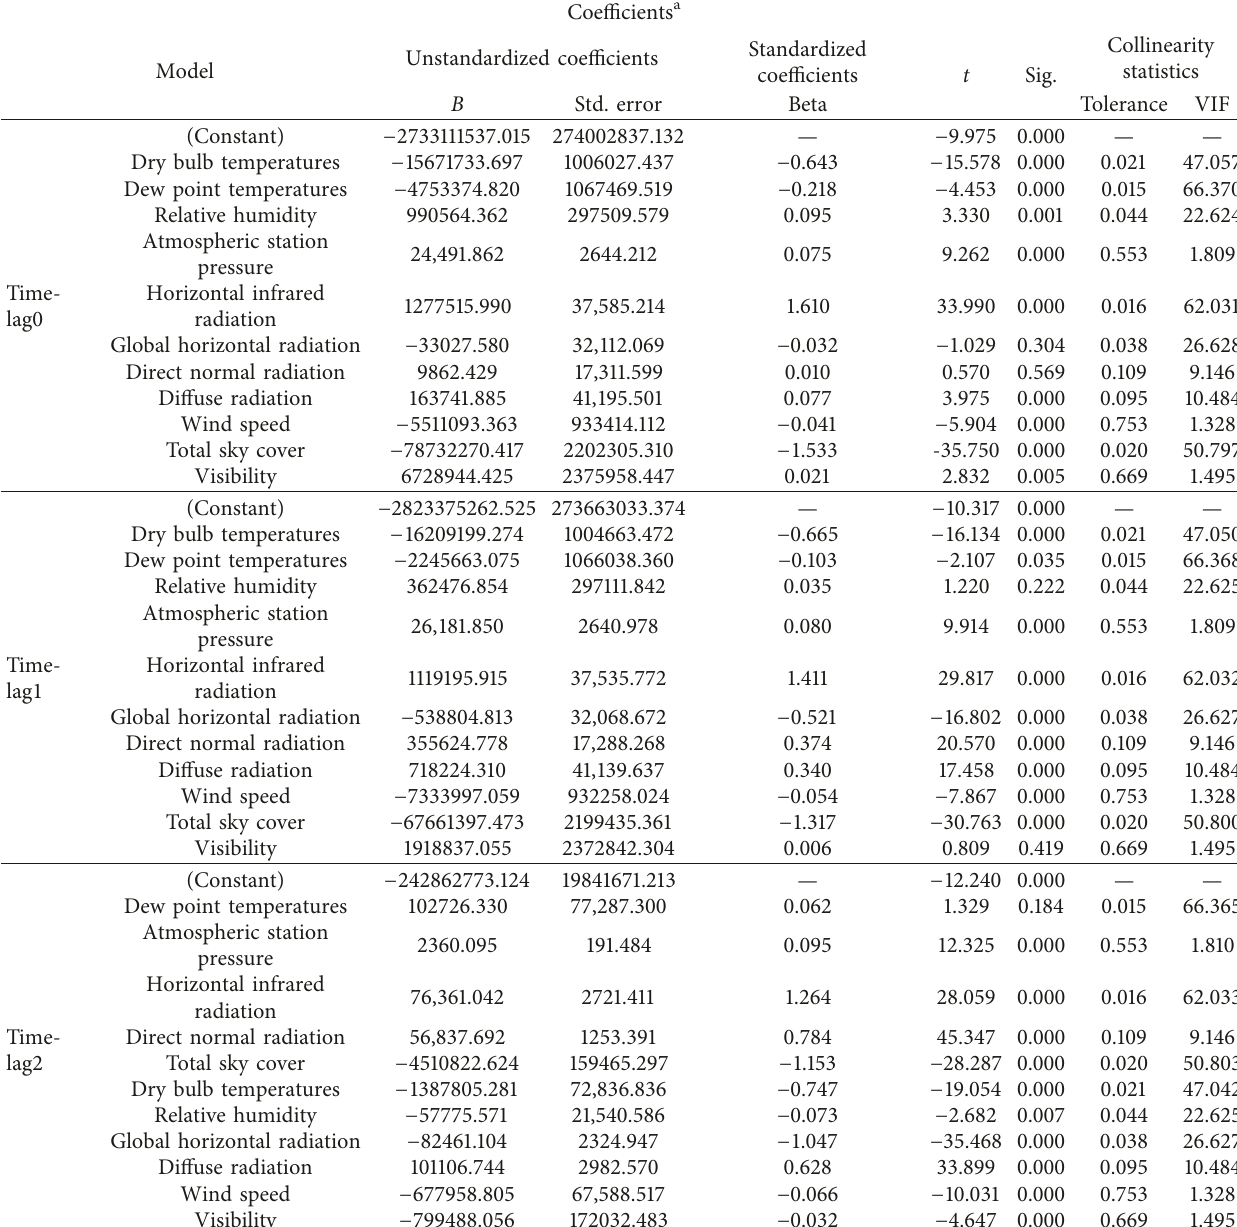
Table 20: Regression coefficients for a DOE large office building depending on